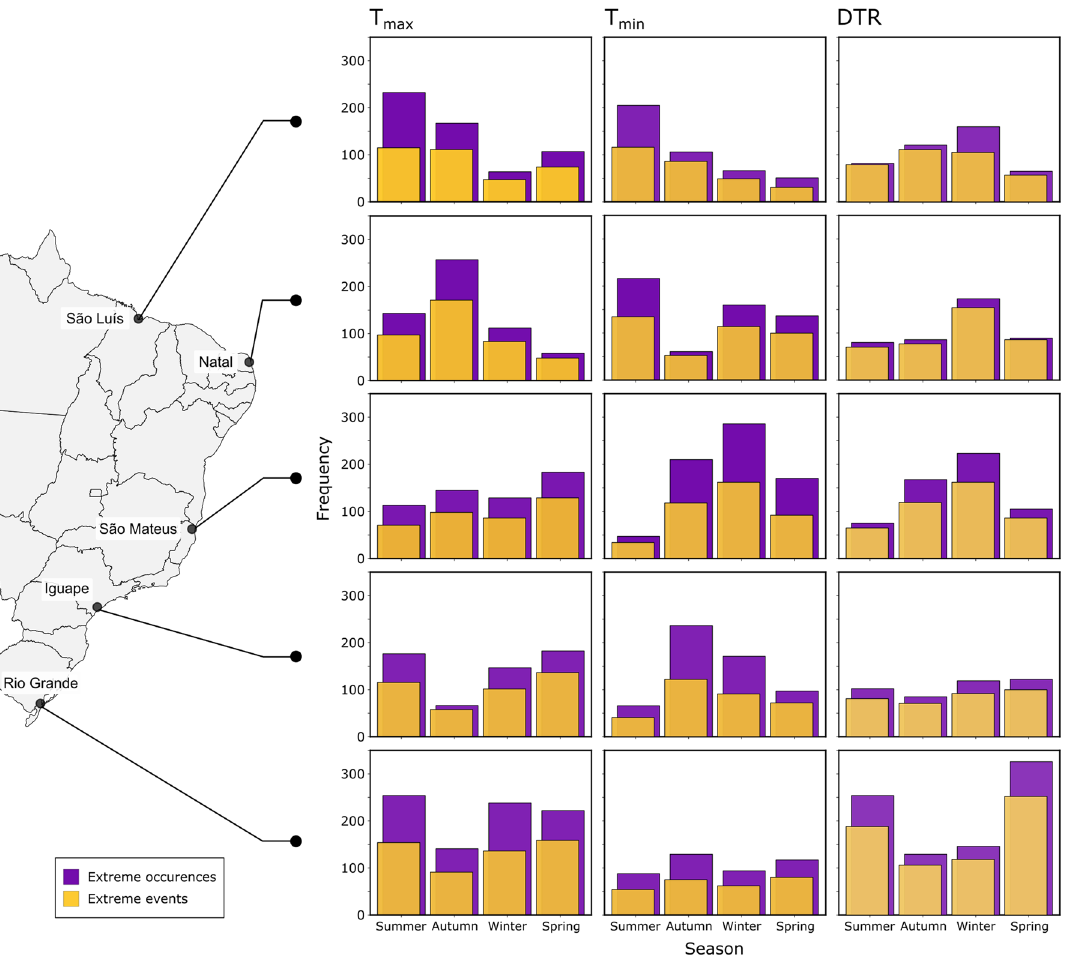
Figure 3. Overall seasonal frequency of extreme occurrence and events from all 5 MEOW in the last 40 years. The results are presented to the following response variables: daily maximum temperatures (T max ); daily minimum temperatures (T min ); and daily temperature range